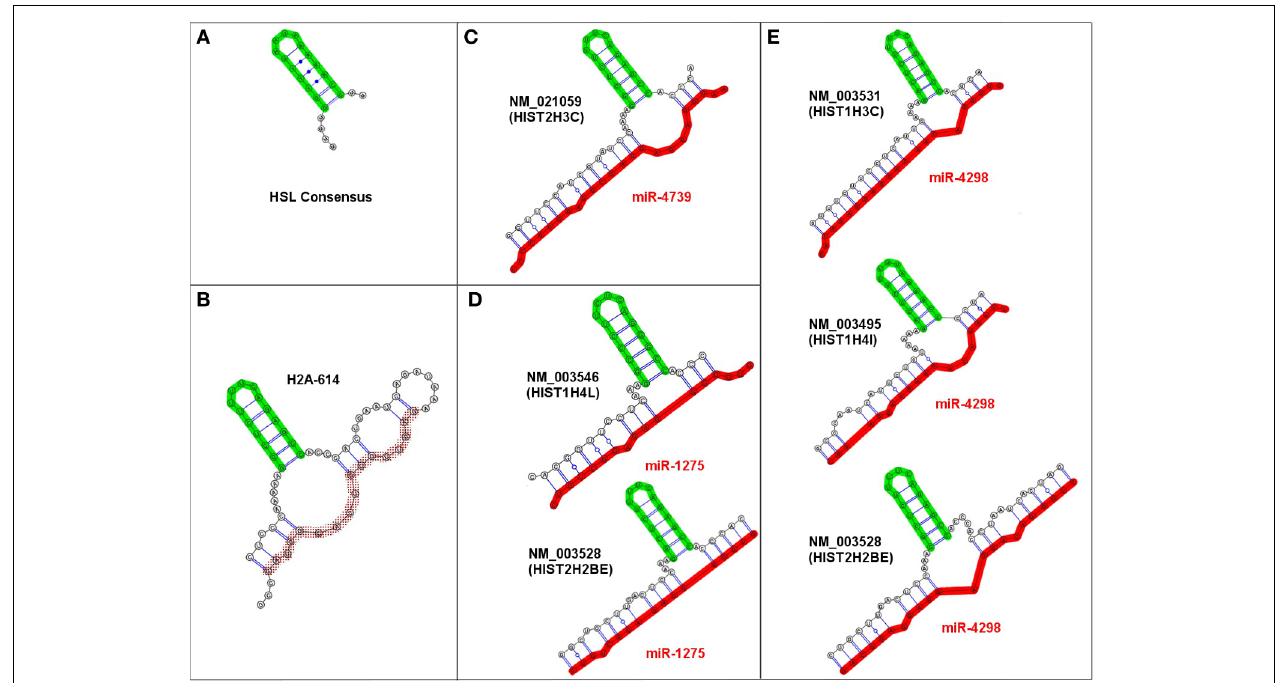
FIGURE 3 | Examples of predicted HSL-sxRNA structures depicted using RNAcofold. (A) The consensus HSL. (B) The pre-processed HSL sequence containing the histone downstream element sequence predicted to form a cis-three way junction structure that is similar to the trans sxRNA (Zhang et al., 2012). (C–E) Representative predicted HSL-sxRNA structures for miR-4739, miR-1275, and miR-4298. Three representative miRNAs (miR-4739, miR-1275, and miR-4298) potentially